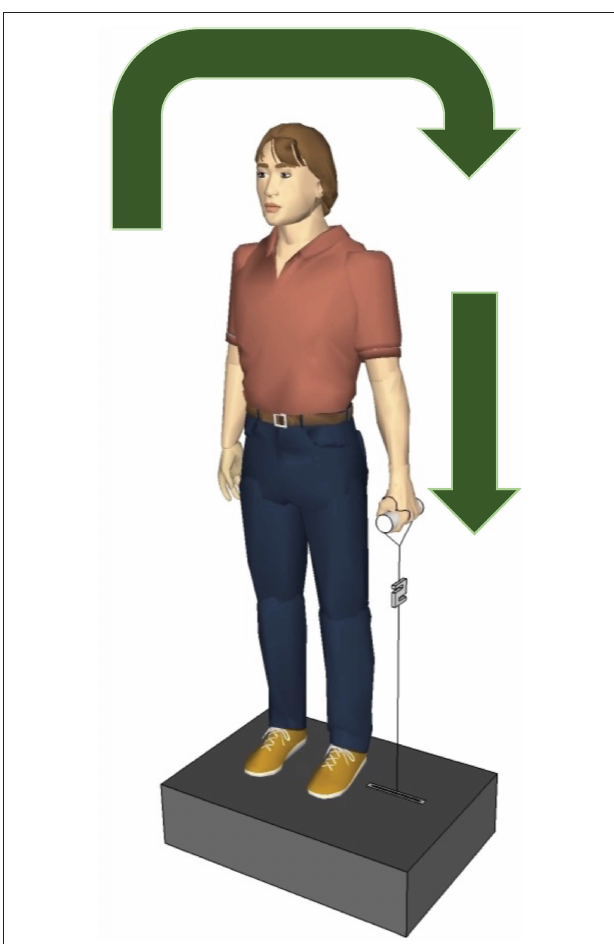
FIGURE 1 | Experimental setup. The participants held the handle in the left and the right hand, one after the other, the servo motor vertically pulled the handle producing a sudden lateral perturbation to the trunk. The arrows show the direction of the body move after